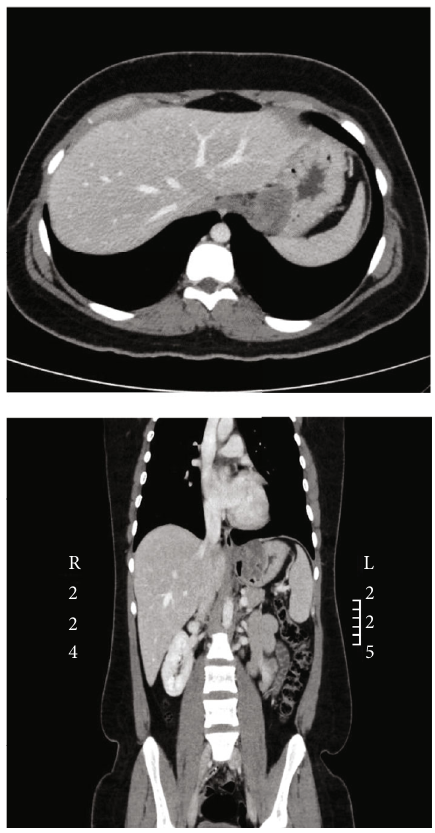
Figure 1: CT images showing a gastric mass. A 4.7 cm lobulated submucosal gastric mass at the gastric cardia near the gastroesophageal junction. The mass has an exophytic component abutting the left hemidiaphragm and left liver lobe.